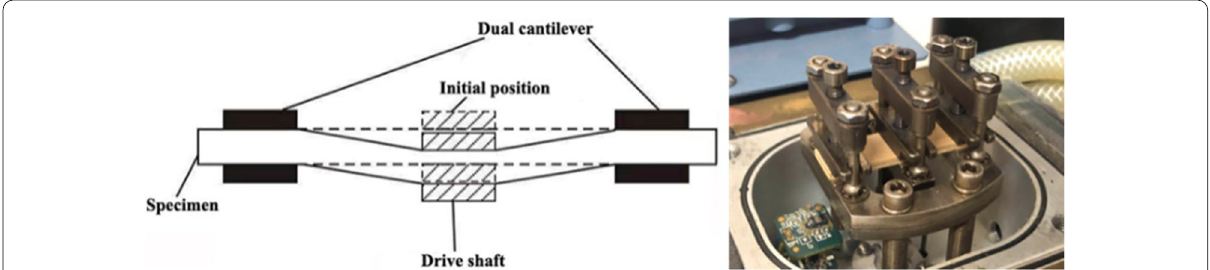
Fig. 2 Schematic diagram of double cantilever